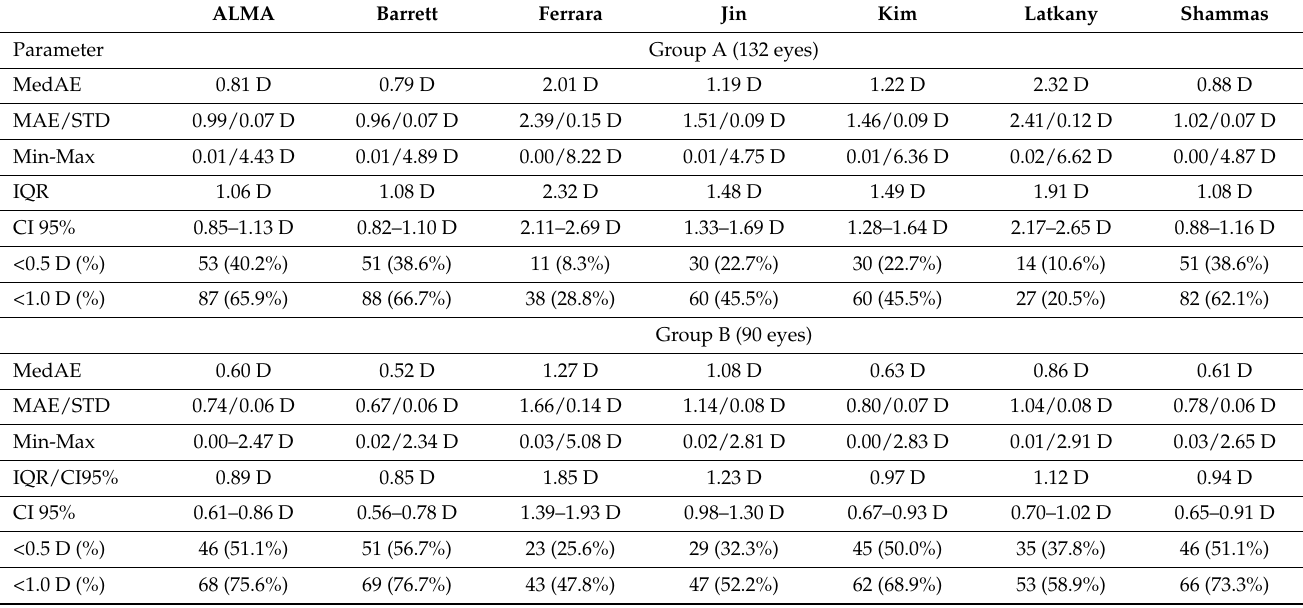
Table 1. Comparison of refractive outcome among examined formulas (Group A and Group B).